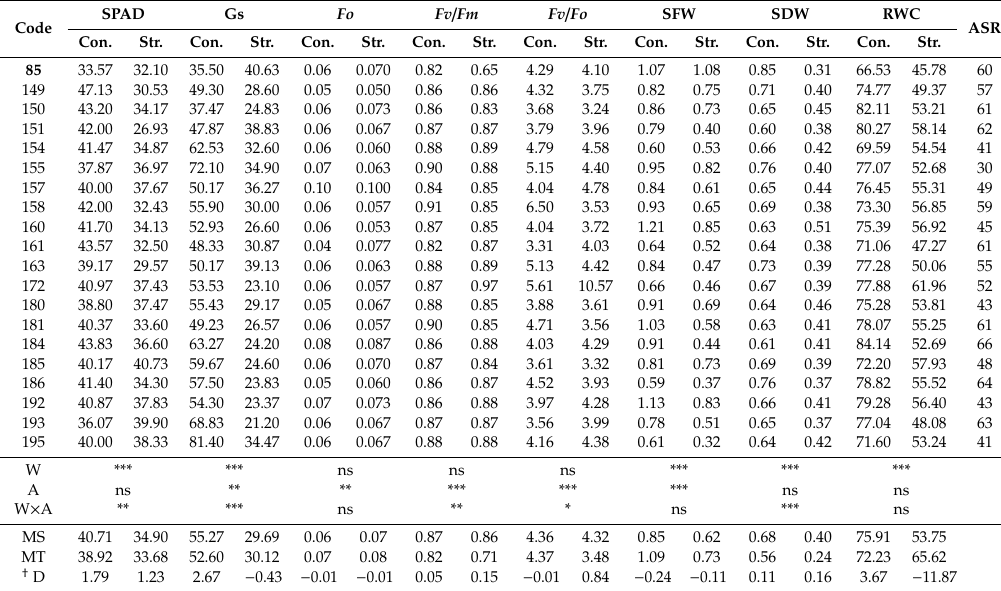
Table 2. Mean values of physio-chemical traits and shoot biomasses in the selected accessions for water deficit stress condition.